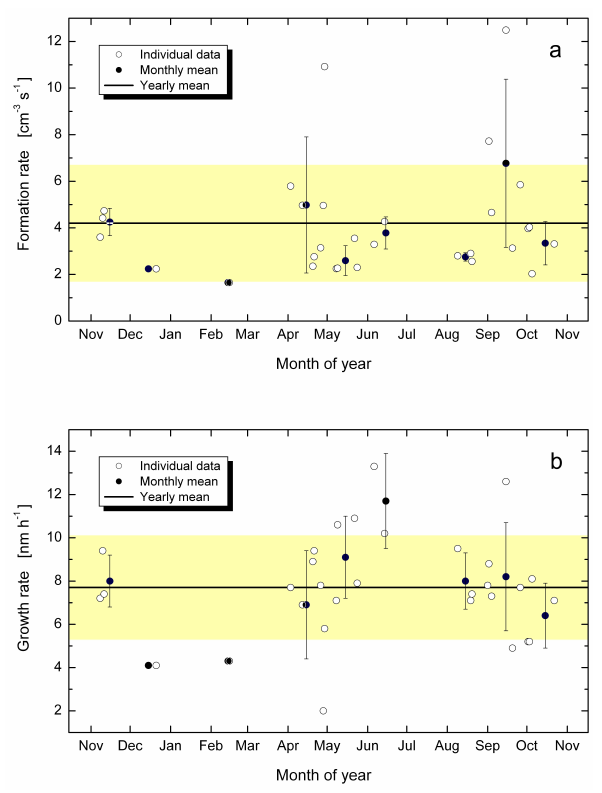
Fig. 8. Formation rates of aerosol particles with a diameter of 6nm (a) , and growth rate of the nucleation mode with a median diameter of 6nm (b) in Budapest from 3 November 2008 to 2 November 2009. Error bars represent standard deviations. Standard deviation of the yearly mean is indicated by yellow